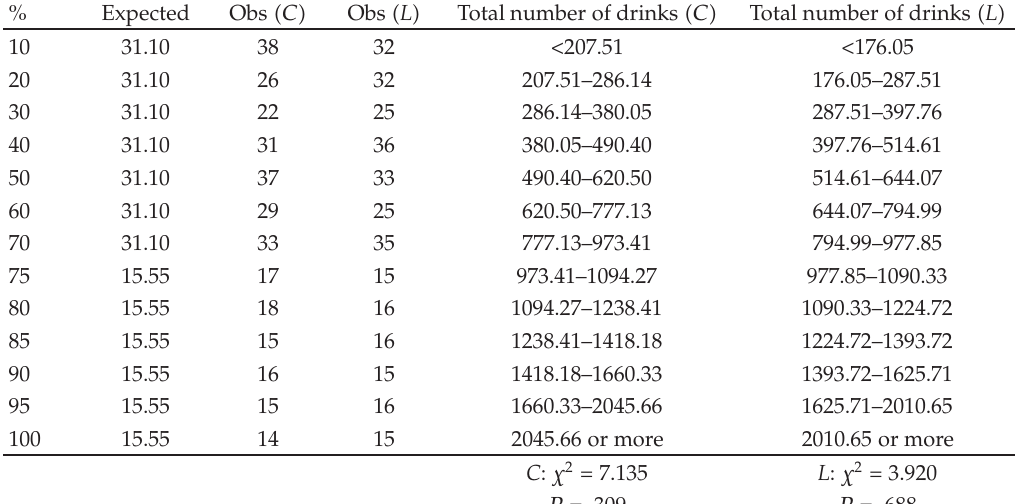
Table 5: Chi-square goodness of fit statistics for the conventional (cid:2) C (cid:3) moment and L -moment approximations for the TSF group data (cid:2) n (cid:7) 311 (cid:3) in Figure